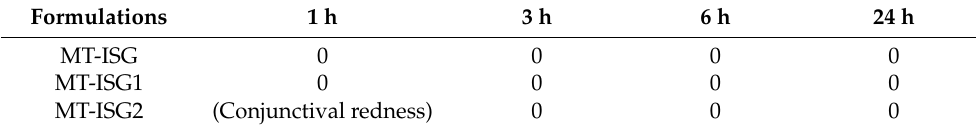
Table 4. Scores obtained in Draize’s test of various formulations in rabbit eyes.